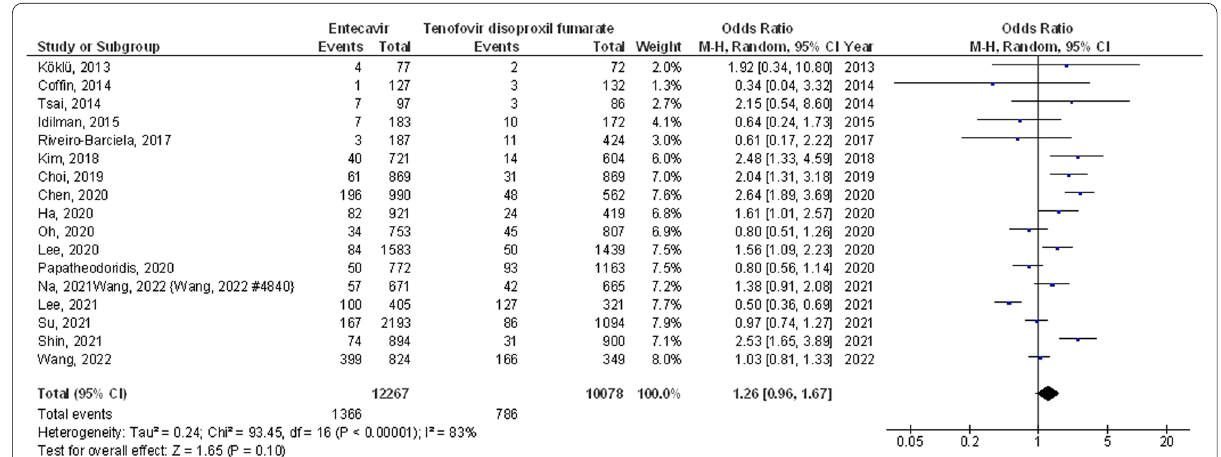
Fig. 3 Difference between the impact of entecavir and tenofovir disoproxil concerning HCC occurrence in chronic HBV